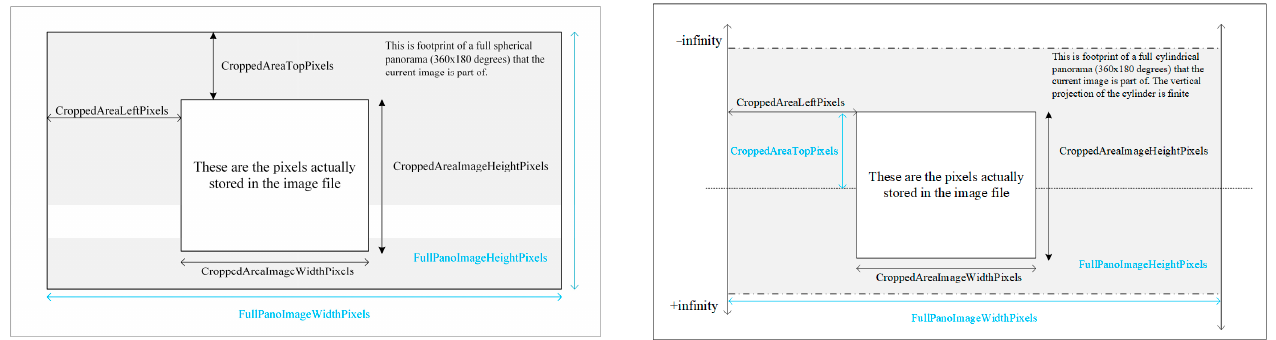
Figure 3. GPano properties: spherical ( left ) and cylindrical ( right